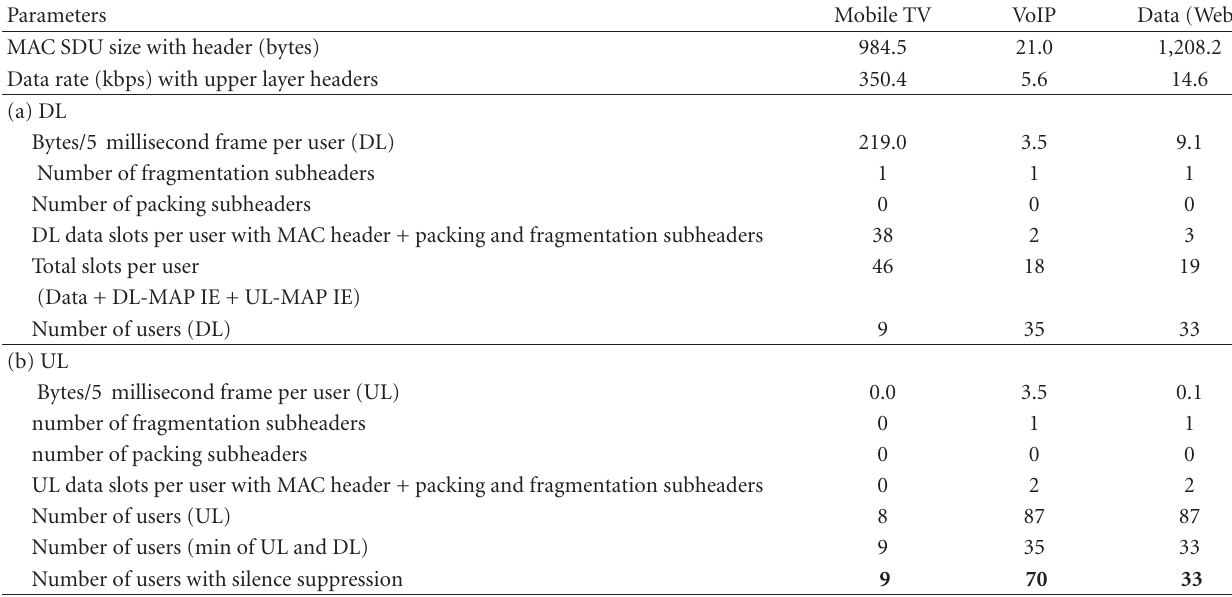
Table 10: Example of capacity evaluation using a simple